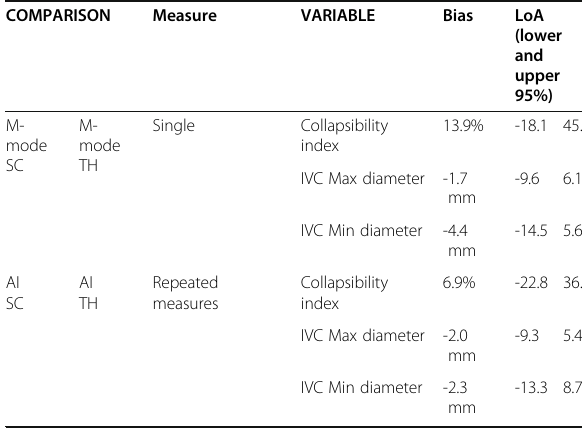
Table 1 (abstract A122). See text for